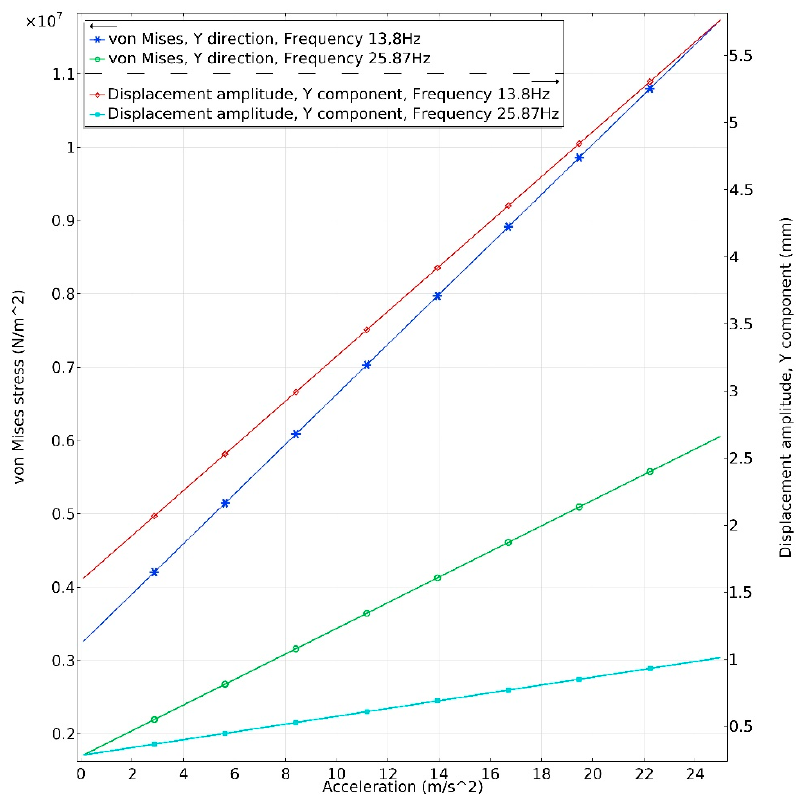
Figure 7. Dependence of maximum von Mises stress and tip displacement from acceleration in z direction.